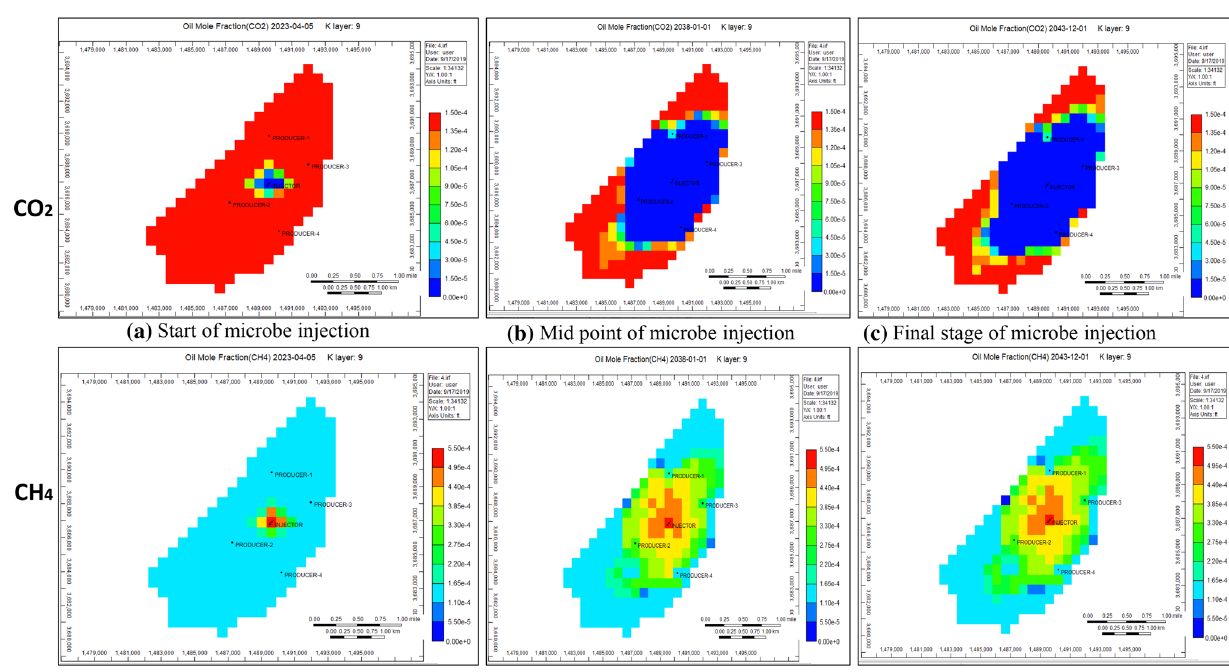
Fig. 18 CO 2 (top) and CH 4 (bottom) saturation maps